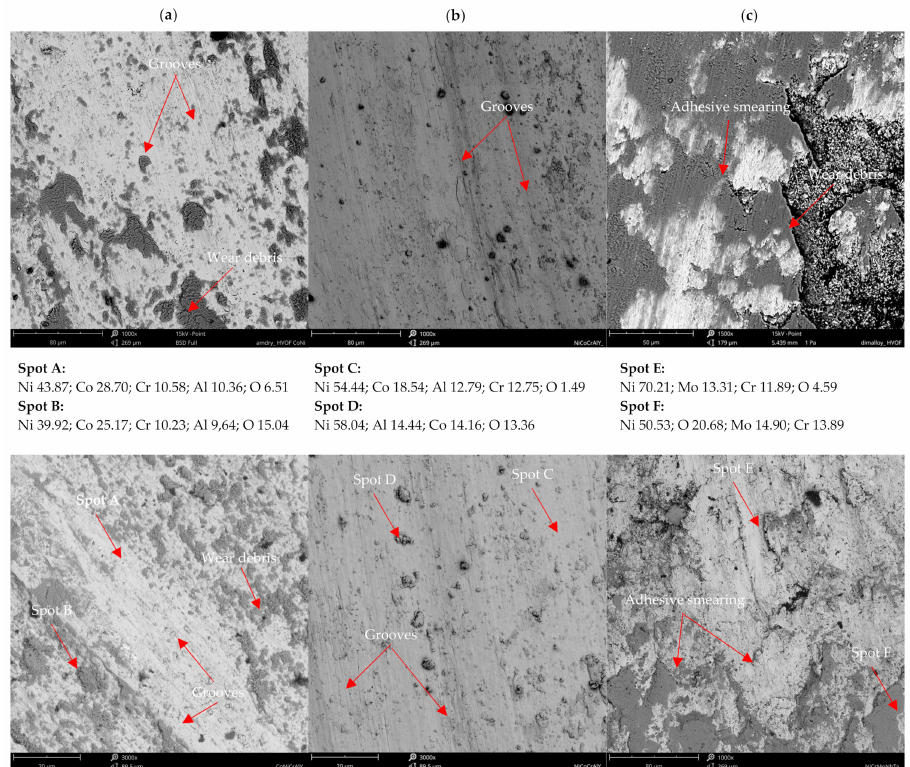
Figure 11. Wear traces and spot chemical analysis: ( a ) CoNiCrAlY, ( b ) NiCoCrAlY, ( c ) NiCrMoNbTa wear trace, SEM-EDS in